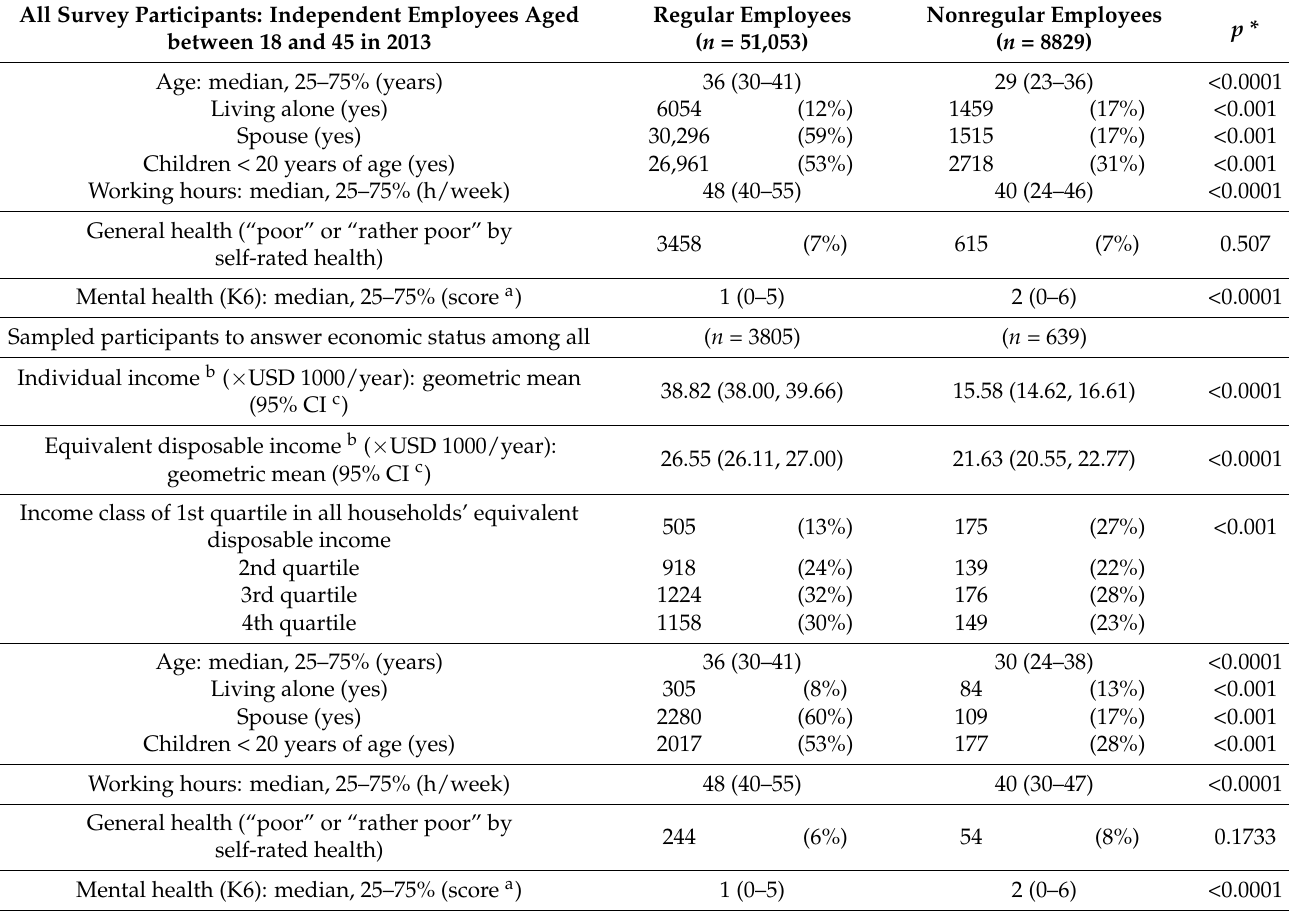
Table 1. Basic characteristics of male employees (upper: all survey participants with and without income information; lower: participants with income